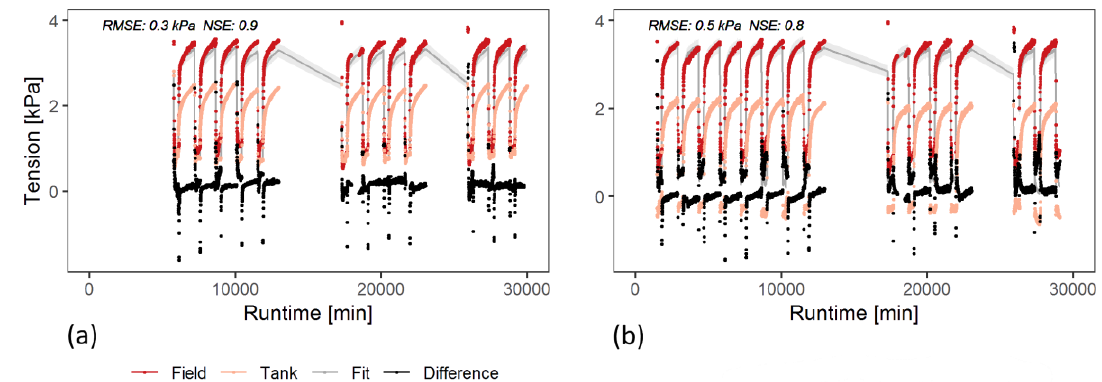
Figure 7. Tension measurements of the upper layer during scenario 2 for ( a ) the FIU / tank and ( b ) the FIU / column experiments and the adapted laboratory tension values by regression function, with a 95% confidence interval (Fit).